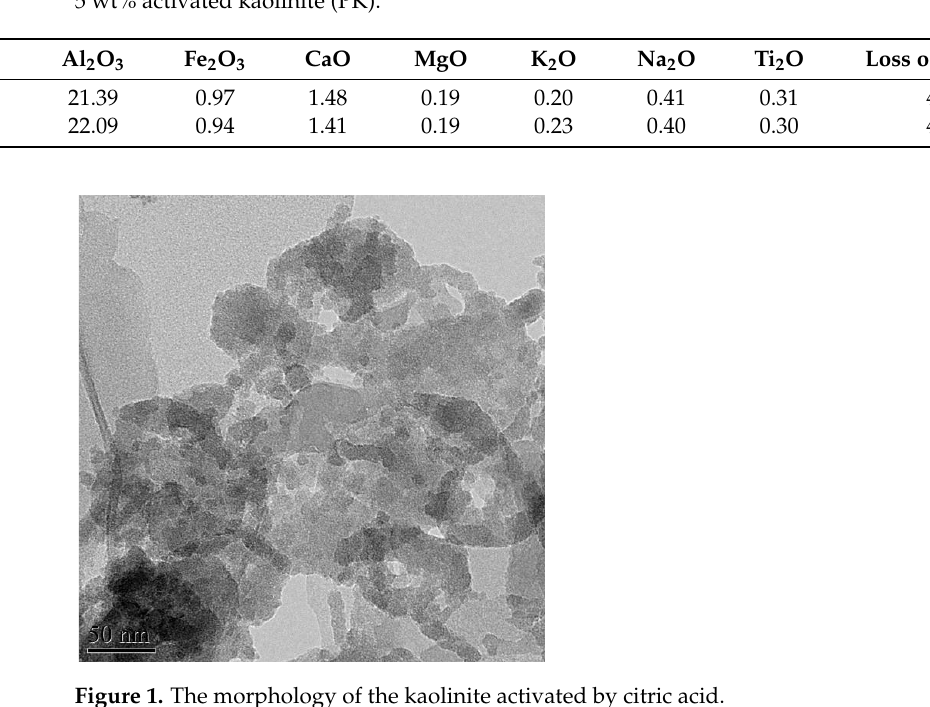
Figure 1. The morphology of the kaolinite activated by citric acid. The powders of P and PK were ball milled (QM-3SP2 planetary ball mill, Nanjing Nanda Instrument Plant Co. Ltd., Nanjing, China) in distilled water for 6 h using poly- ethylene bottles with zirconia ball media. After drying at 85 ± 1 °C in air, the powders were ground in an agate mortar and passed through a 200 mesh nylon sieve. Specimens were fabricated by dry-pressing moulding (120 mm (L) × 20 mm (W) × 3mm (H)) at 20 MPa (Figure 2). The green specimens were fired in air at 1270 °C, 1350°C in an electric furnace at a heating rate of 5 °C/min in air, and then they remained at these tempera- tures for 2 h before cooling the furnace. The porcelain from the raw material was marked M1, and the porcelain from the materials mixed with 5% activated kaolin was marked M2. Figure 2. The image of the laboratory specimens obtained. 2.2. Methods The chemical compositions of the samples were analyzed by XRF Spectrometry (PANalytical Axios PW4400, Amsterdam, Holland) with a fusion dissolution technique. The thermal behavior of the samples was investigated by thermal gravity analysis and differential scanning calorimetry (TG-DSC) in air, by a NETZSCH STA 449C (NE-